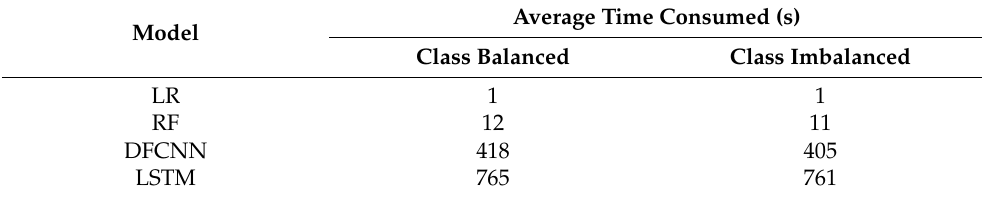
Table 4. Average time consumed by different LSA